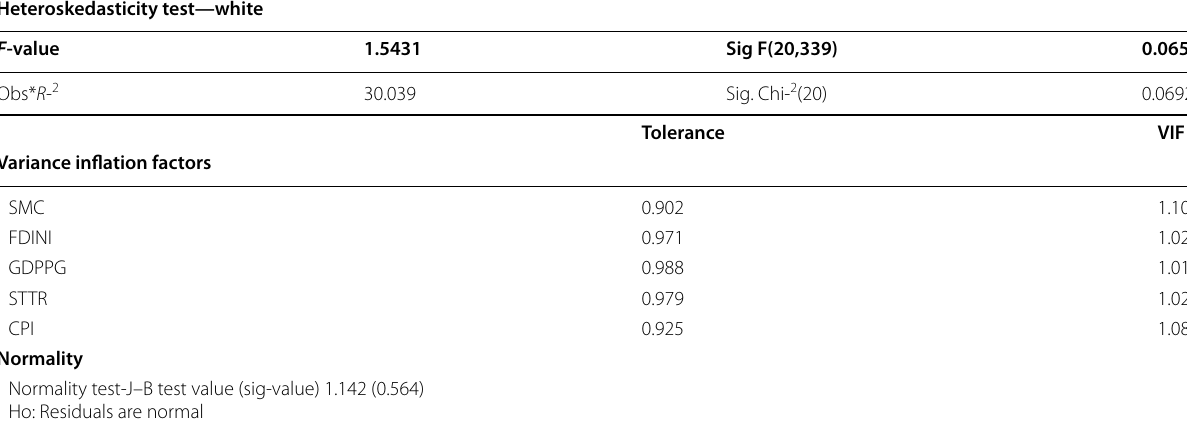
Table 9 Heteroskedasticity, normality, variance inflation factors. Source: Software of E-views 10 output Heteroskedasticity